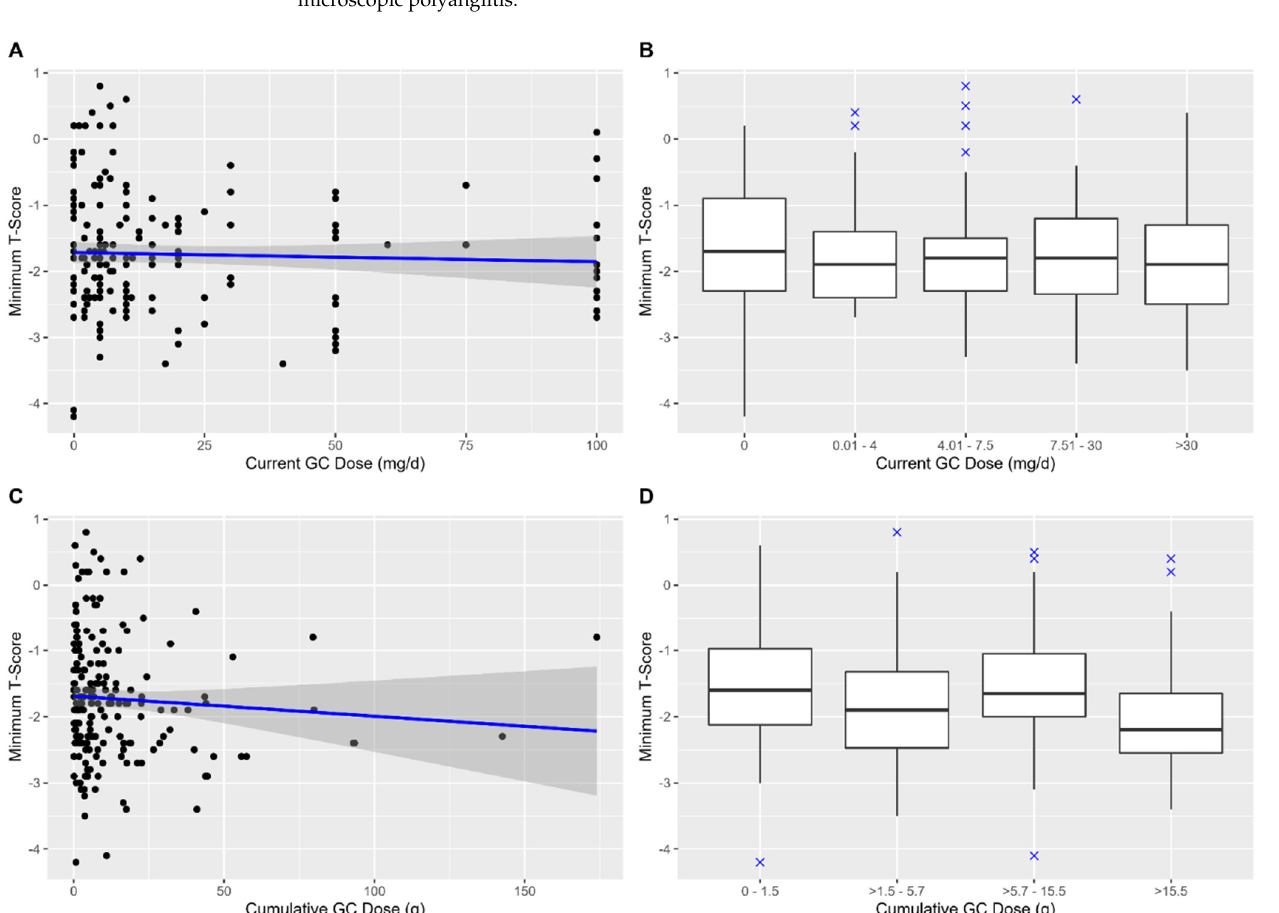
Table 4. Results of adjusted multiple linear regression analyses with minimum T-score as the dependent variable and current and cumulative glucocorticoid (GC) intake as continuous or categorical predictors.